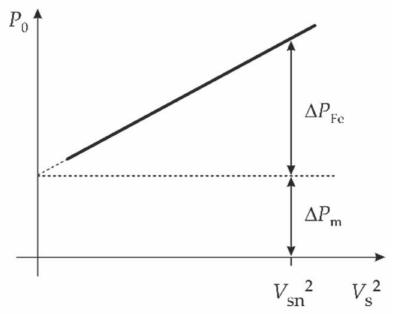
Figure 4. Graphical method for determining the power losses ∆ P Fe